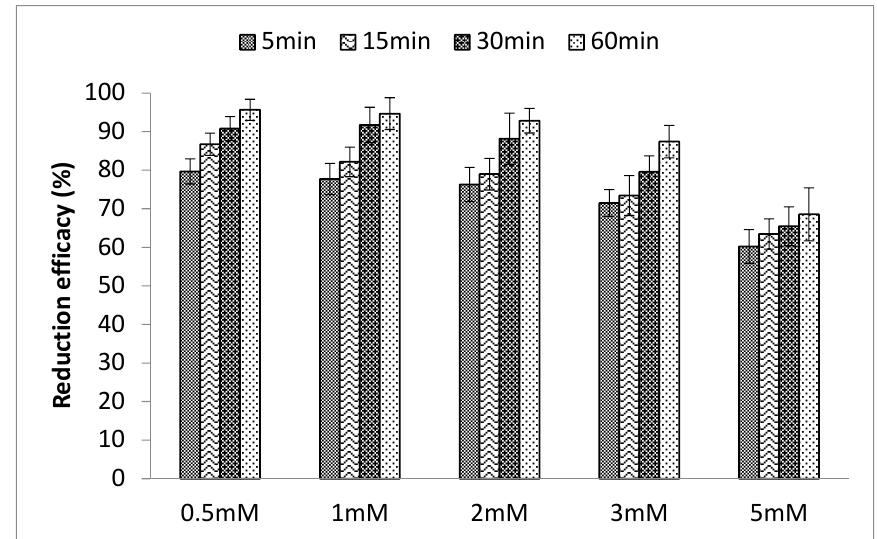
Figure 5. Effects of hardness: [Cr(VI)] 0 = 10 mg·L − 1 , Cr(VI) volume = 25 mL, contact time = 60 min, pH = 2, PLE quantity = 1.5 mL, hardness = 0.5–5 mM.